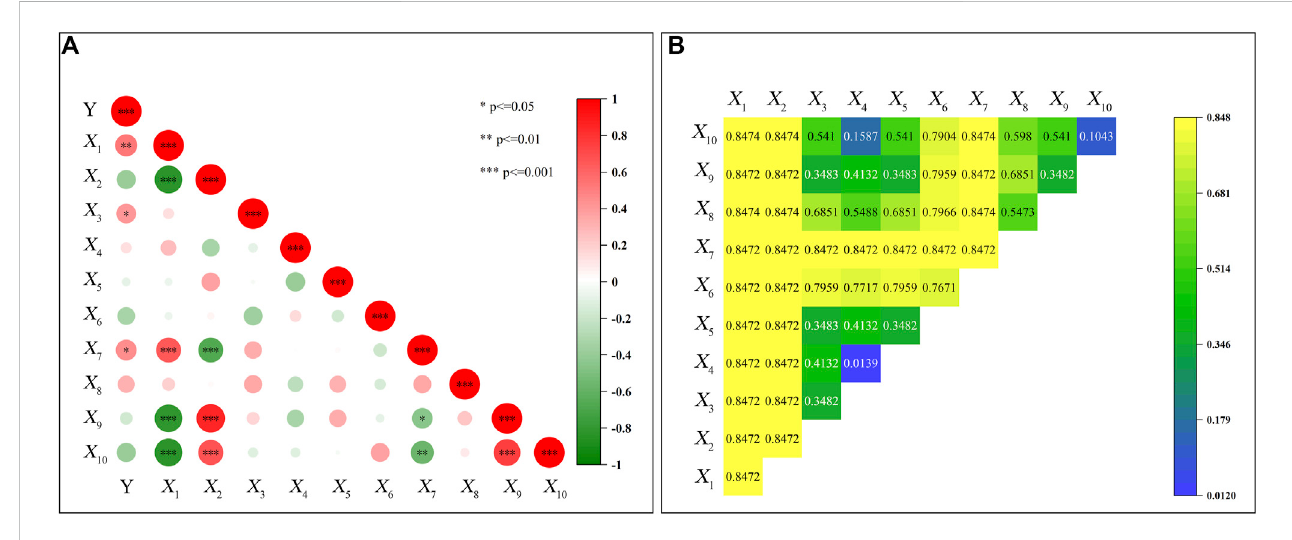
FIGURE 5 Driving factors of ecological risk in the Savan District: (A) factor correlation; (B) interactive detection results.